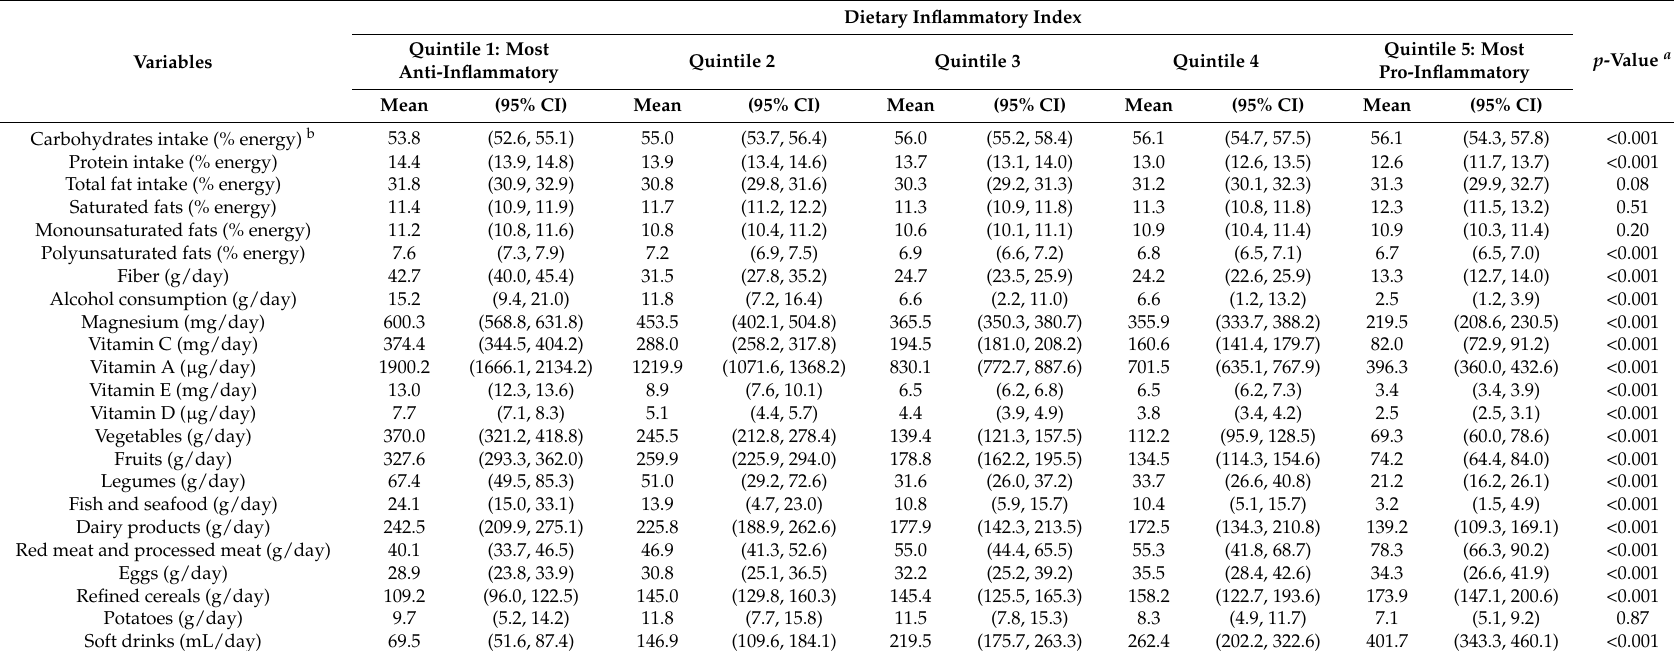
Table 3. Nutrient and food consumption according to quintiles of the dietary inflammatory index: in the Diabetes Mellitus Survey of Mexico City, 2015.